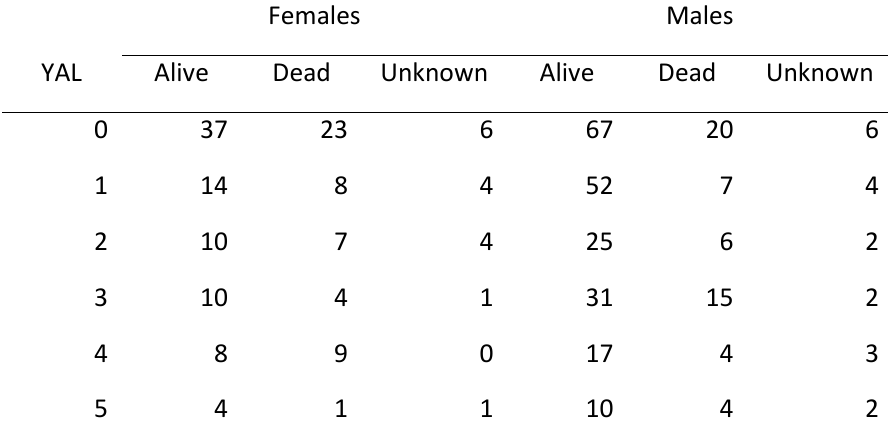
Table 20. Total recaptures by years at large (YAL) for trawl captured, unbled male and female horseshoe crabs since